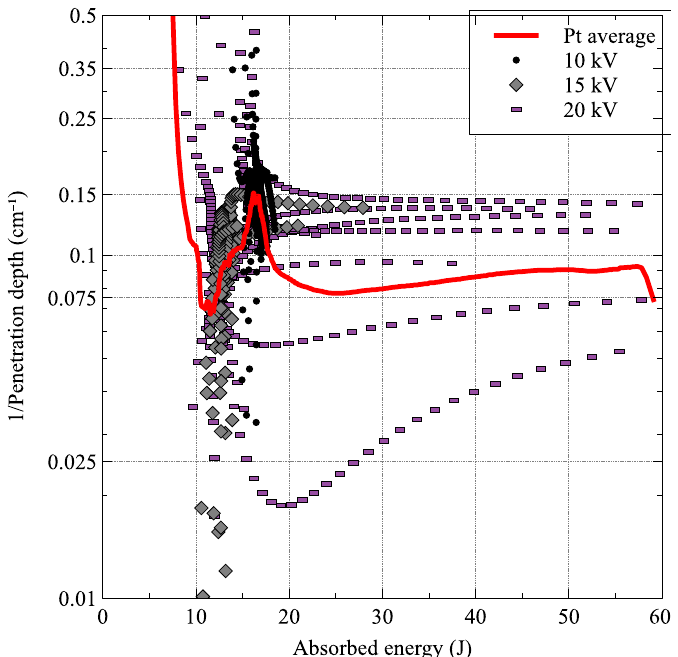
Figure 11. (Color online) penetration of platinum metal gas as a function of the metal absorbed energy. Average values are shown as a guide to the eye.